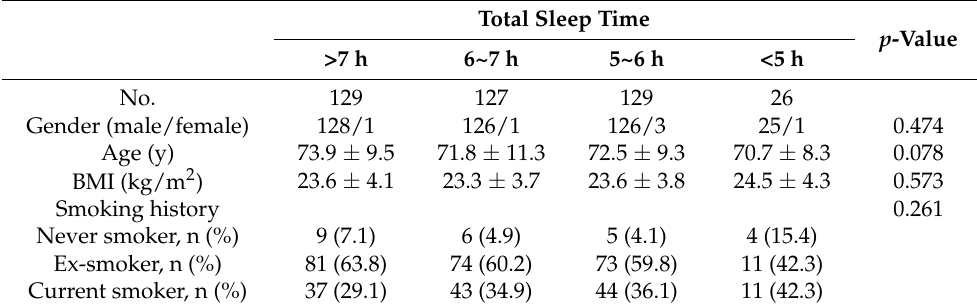
Table 1. Basic data from four groups according to total sleep